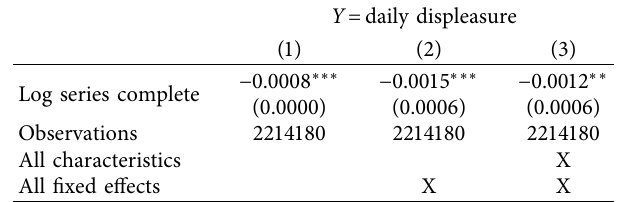
Table 4: Vaccination and displeasure. Table 5: Vaccination and